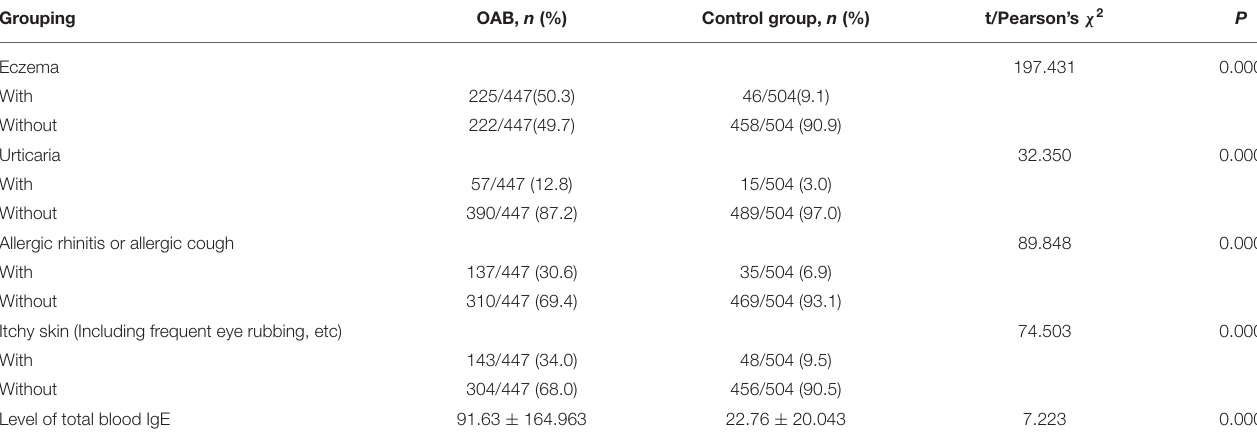
TABLE 2 | Univariate analysis of the risk factors in children with OAB.